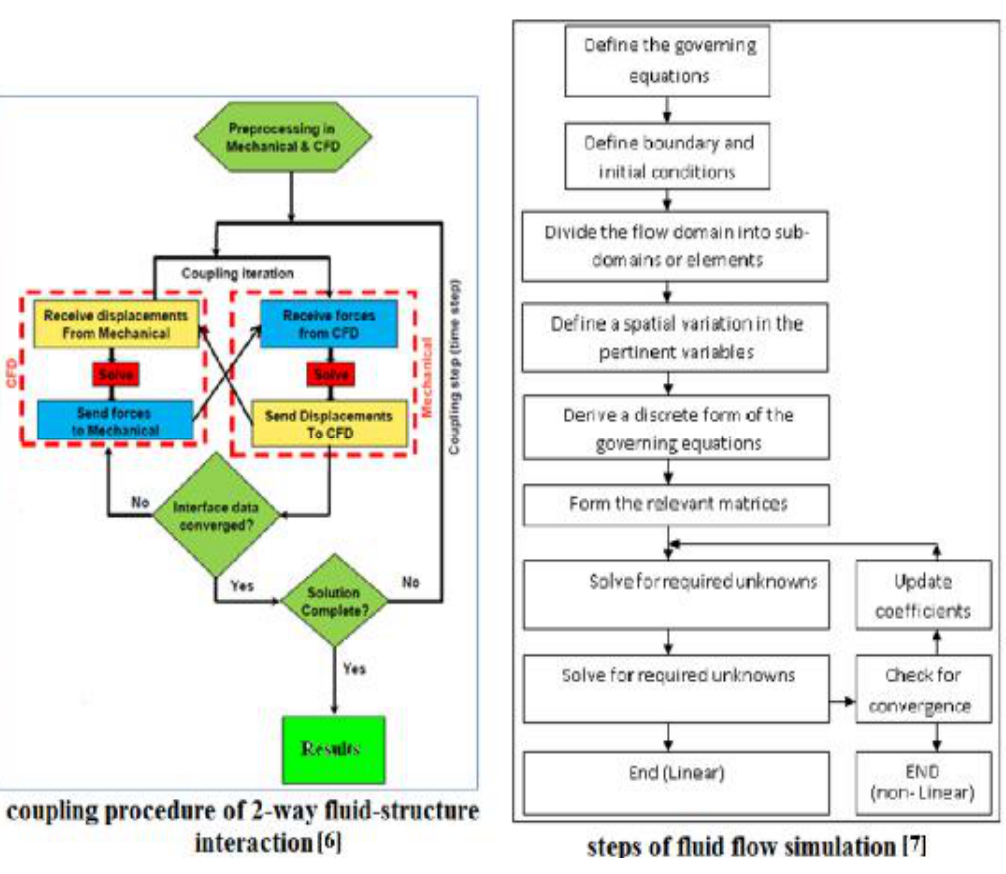
Fig. 1. Coupling procedure and numerical simulation steps.